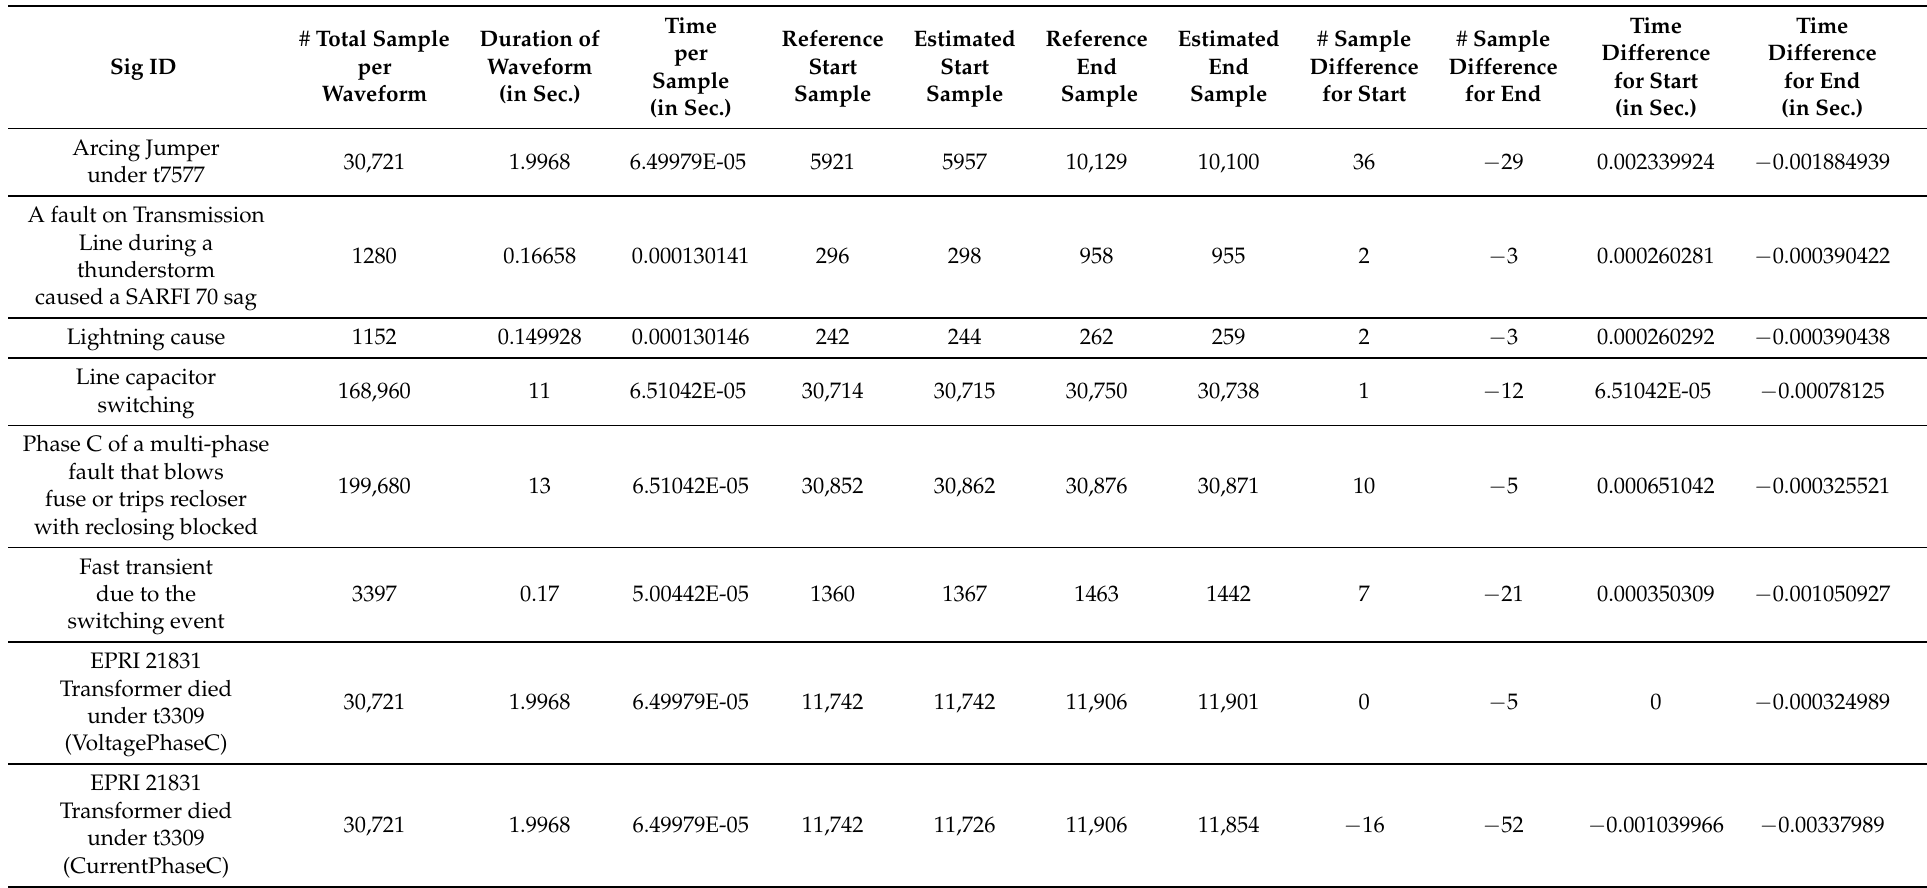
Table 2. Performance results of the proposed energy detector with respect to the reference data provided from the Grid Signature Library [19] and EPRI/DOE